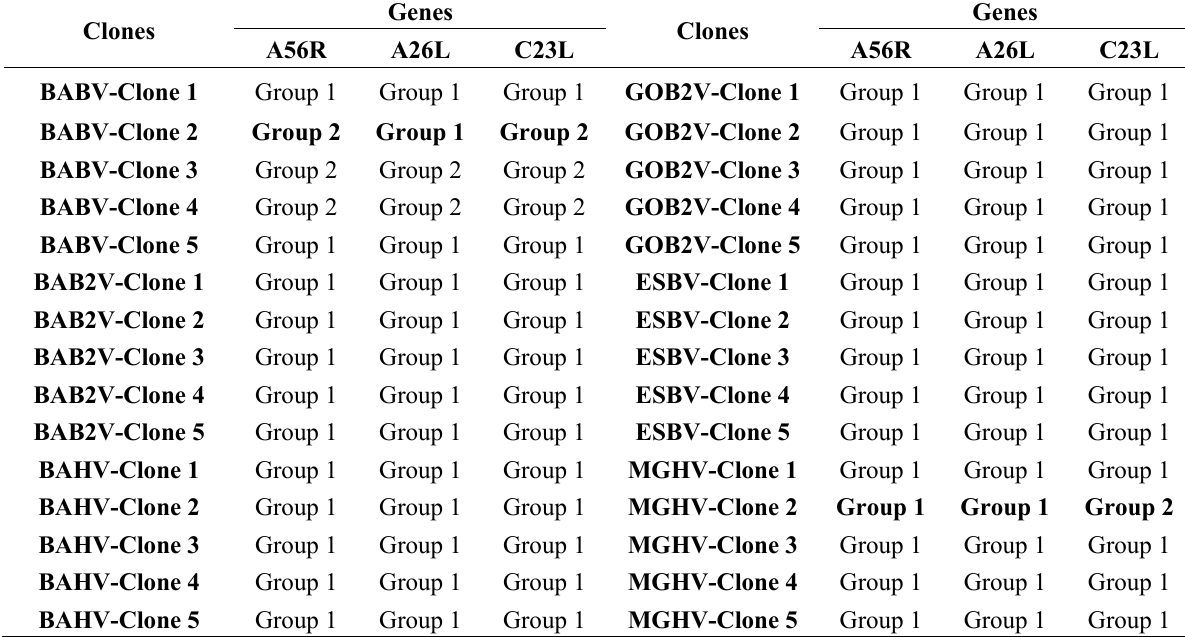
Table 2. VACV-BR group 1 or 2 profile of the isolated clones based on A56R, A26L and C23L genes. Bold font indicates clones with mixed profile (Group 1 and